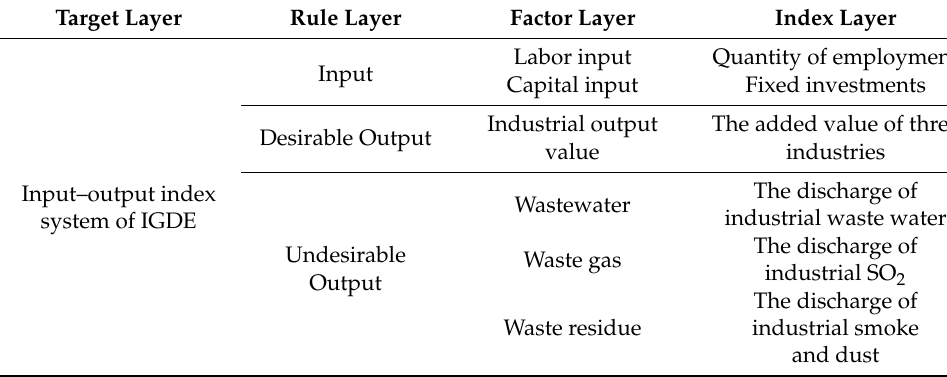
Table 1. Input–output index system of industrial green development efficiency